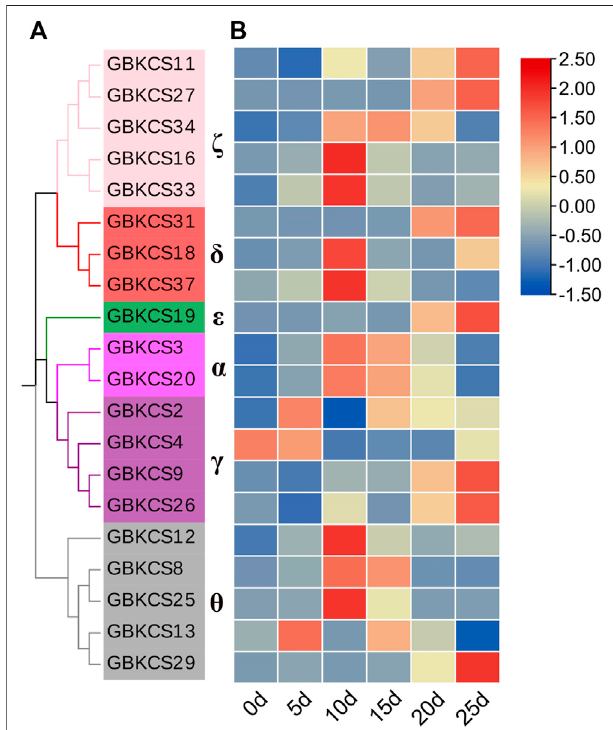
FIGURE 9 | Analysis of the expression patterns of 20 genes in the GBKCS genefamily. (A) Theevolutionaryrelationshipof20 GBKCS genes. (B) Expression model of 20 GBKCS genes at different stages of fi ber development. Each column represented the expression of different genes in the same sample, and each row represented the expression of the same gene in different samples. The heat map was drawn with TBtools